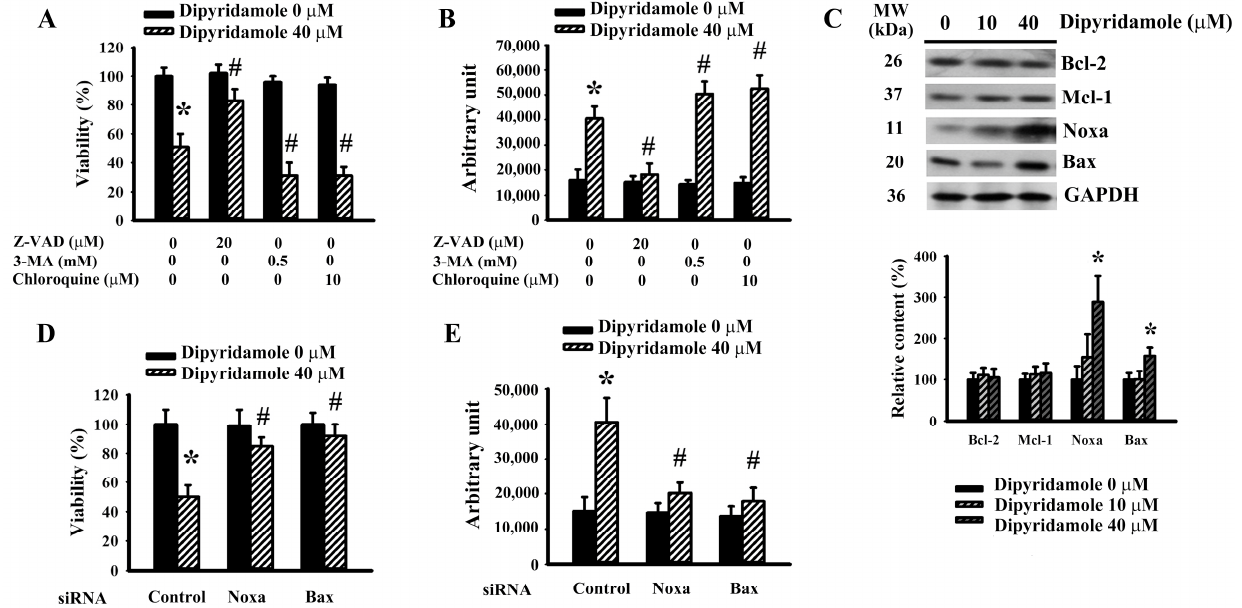
Figure 2. Dipyridamole elevated Noxa expression and caused apoptosis in U87 cells. U87 cells were treated with dipyridamole (0 and 40 μ M) in the presence or absence of Z-VAD (20 μ M), 3-MA (0.5 mM), and chloroquine (10 μ M). ( A ) Cell viability (24 h) was determined using MTS reduction assay. ( B ) Caspase 3 activity (12 h) was measured using an enzymatic assay. ( C ) U87 cells were treated with various concentrations of dipyridamole, as indicated for 12 h. Proteins were determined using western blotting with indicated antibodies. Representative blots and quantitative results are shown. U87 cells were transfected with control siRNA, Noxa siRNA, and Bax siRNA for 24 h. The resultant transfected cells were treated with dipyridamole (0 and 40 μ M). ( D ) Cell viability (24 h) was determined using an MTS reduction assay. ( E ) Caspase 3 activity (12 h) was measured using an enzymatic assay. * p < 0.05 vs. untreated control and # p < 0.05 vs. dipyridamole (40 μ M) control, n = 4.